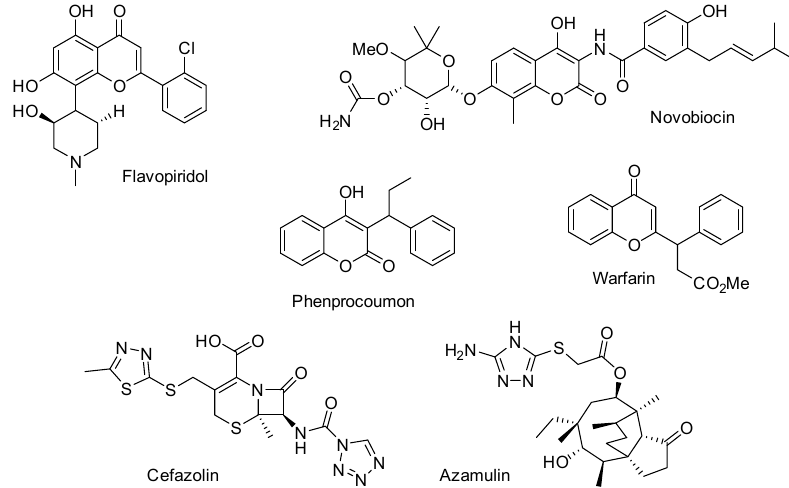
Figure 1. Representatives of clinically used coumarin and thiadiazole derivatives.